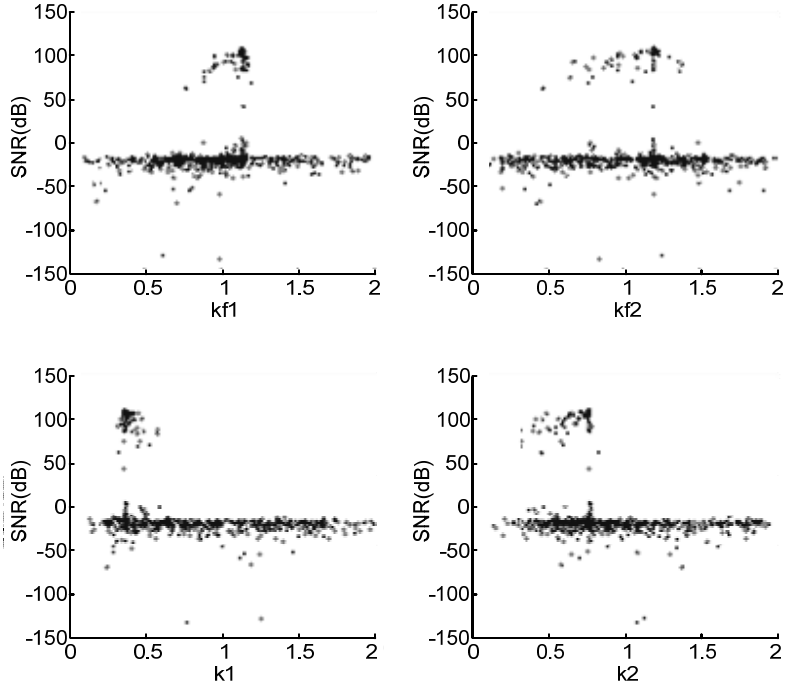
Figure 4. Scatter plot for the EM ΣΔ M gain constants (k1–k2 and kf1–kf2) from the entire GA set of individuals including unfeasible designs.